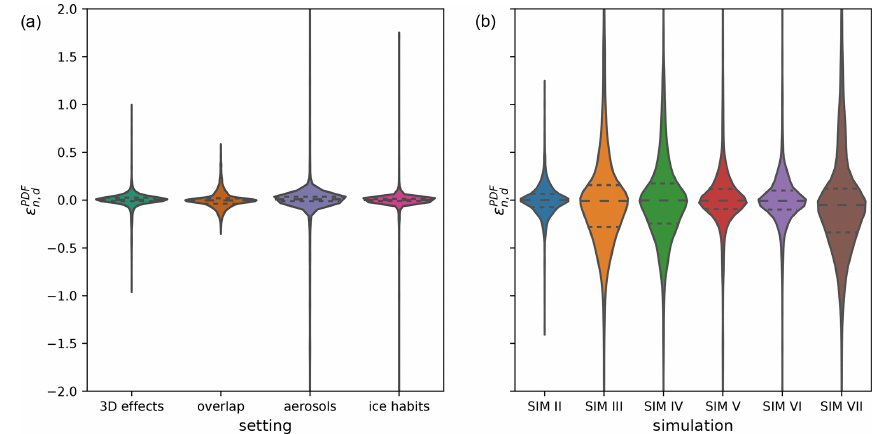
Figure 12. Distributions of daily bin-by-bin differences from the reference run in the 0.6µm SEVIRI solar reflectance as a measure of uncertainty in the visible forward operator (a) and the model (b) . The modified forward operator settings are switching off the cloud-top inclination (3D effects), using random instead of maximum-random subgrid cloud overlap (overlap), including aerosols with an optical depth of 0.1 (aerosols) and changing the cloud ice particle habit to solid columns (ice habits). The perturbed model settings are (II) increased cloud droplet number concentration (smaller effective radius) due to increased updraught velocity at activation, (III) modified distribution of turbulent subgrid liquid clouds (less and thicker subgrid clouds), (IV) stronger shallow-convection parameterisation due to doubled thickness of the thickest unresolved cloud, (V) simulation with the two-moment scheme, (VI) is like (V) but without subgrid-ice clouds, and (VII) is like (VI) but with a reduced number of subgrid-scale liquid clouds. The horizontal dashed lines indicates 25th, 50th (median) and 75th